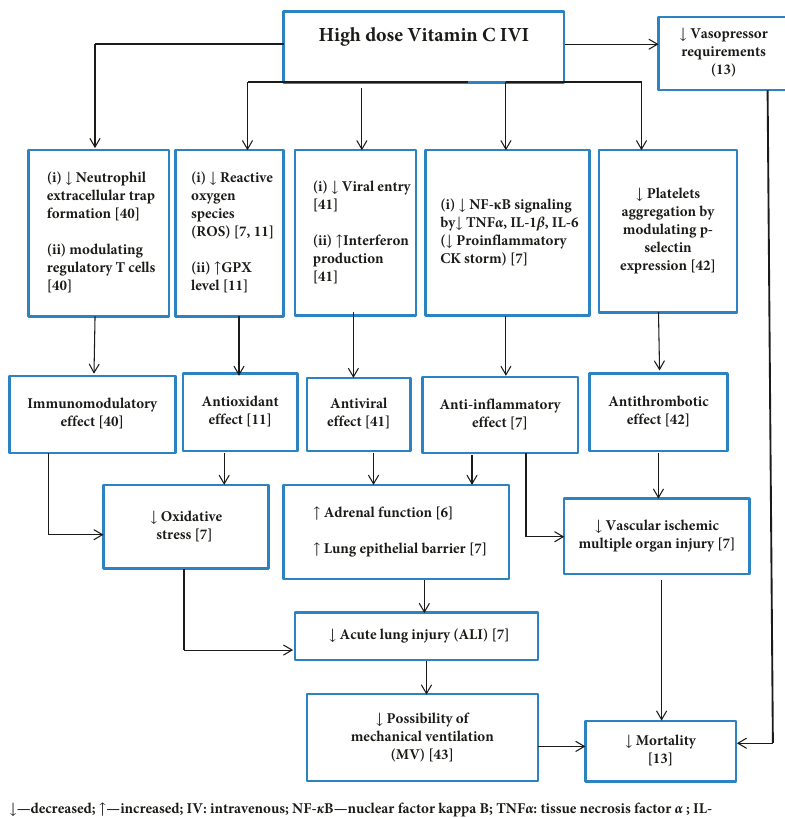
Figure 5: Possible roles of high-dose vitamin C intravenous infusion (IVI) in targeting the pathophysiology of sepsis requiring mechanical